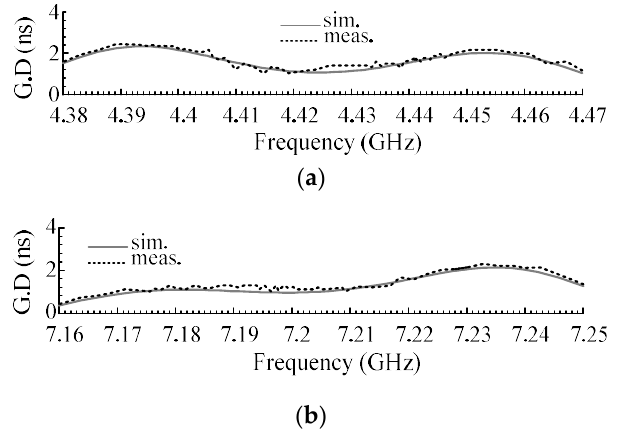
Figure 14. Group delay (GD): ( a ) first passband, ( b ) second passband.